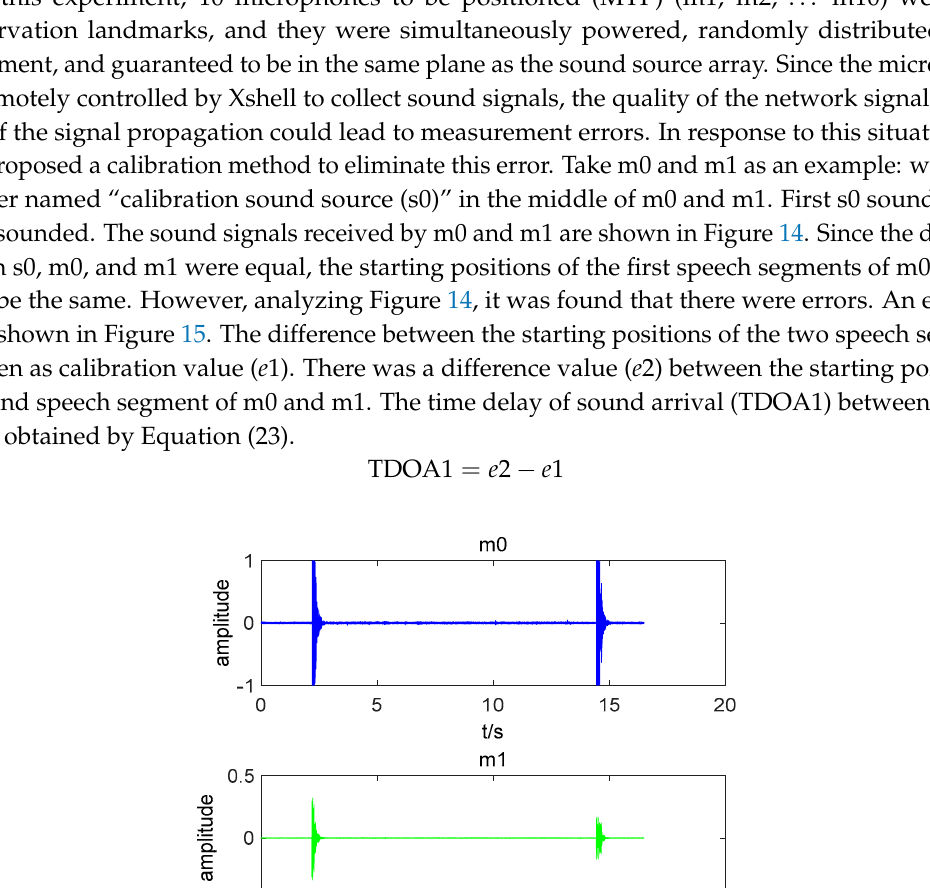
Figure 15. Partially enlarged view of the first speech segments. 4.2.3 Experiment Results We programmed the method to acquire sound signals only when the robot stopped. The experimental verification process of the method is as follows: